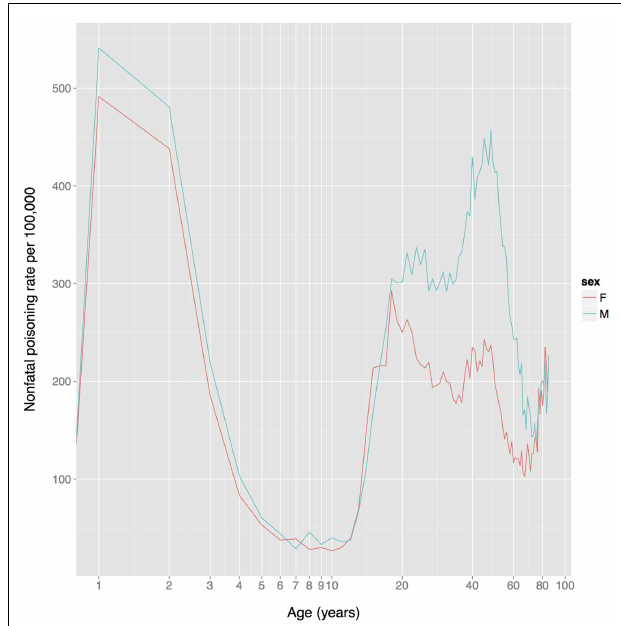
FIGURE 4 | US unintentional non-fatal poisoning rate vs. age, 2001–2011 .There is a dramatic decline in rates during childhood, a dramatic increase during adolescence, and the female (but not male) rate declines steadily during women’s reproductive years (about age 18–38).The x-axis is on a log scale to improve display of the lower age range. Data from Centers for Disease Control and Prevention (168).